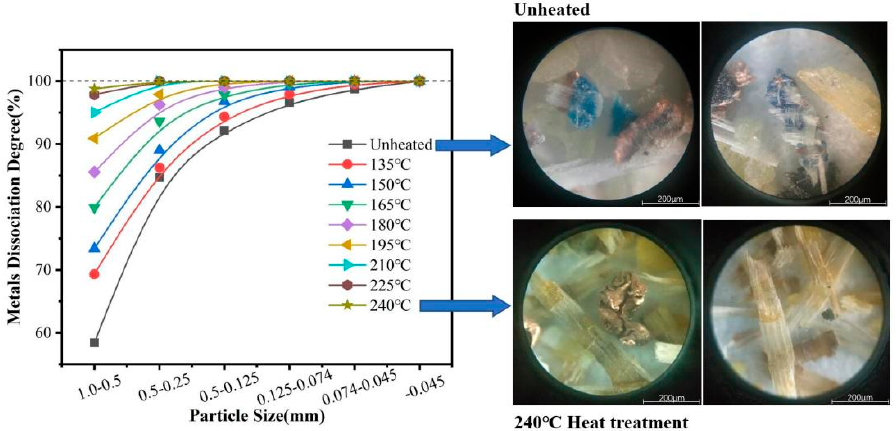
Figure 2. Comparison of the metals liberation degree of PCBs with different heating temperatures.